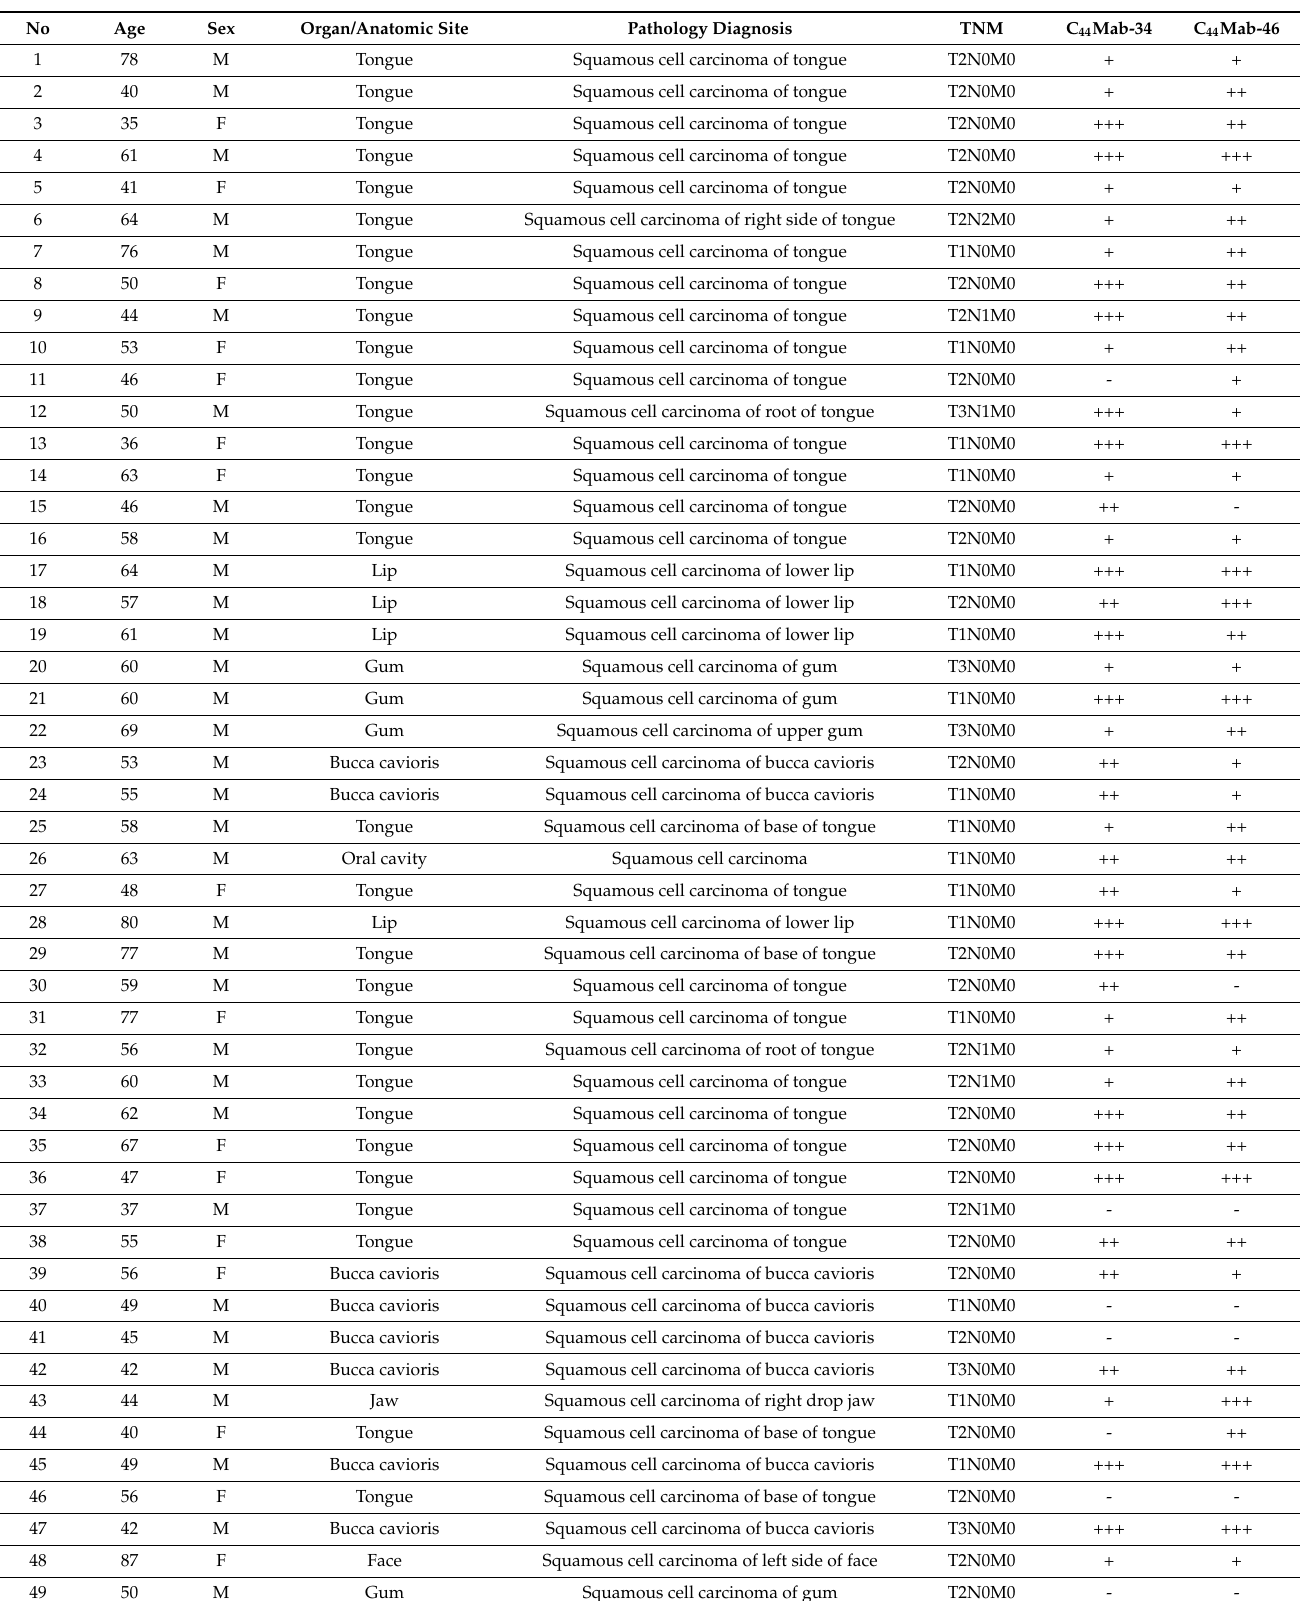
Table 1. Immunohistochemical analysis using C 44 Mab-34 and C 44 Mab-46 against